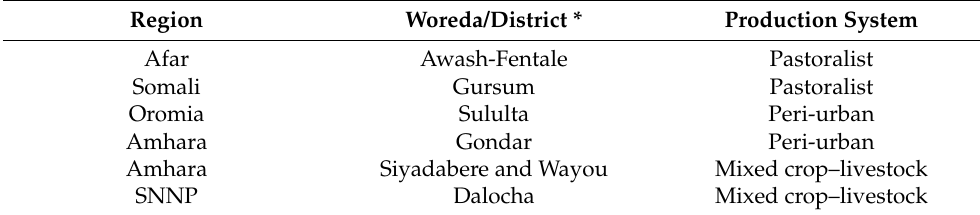
Table 1. Region, district, and production systems of the six study areas *.